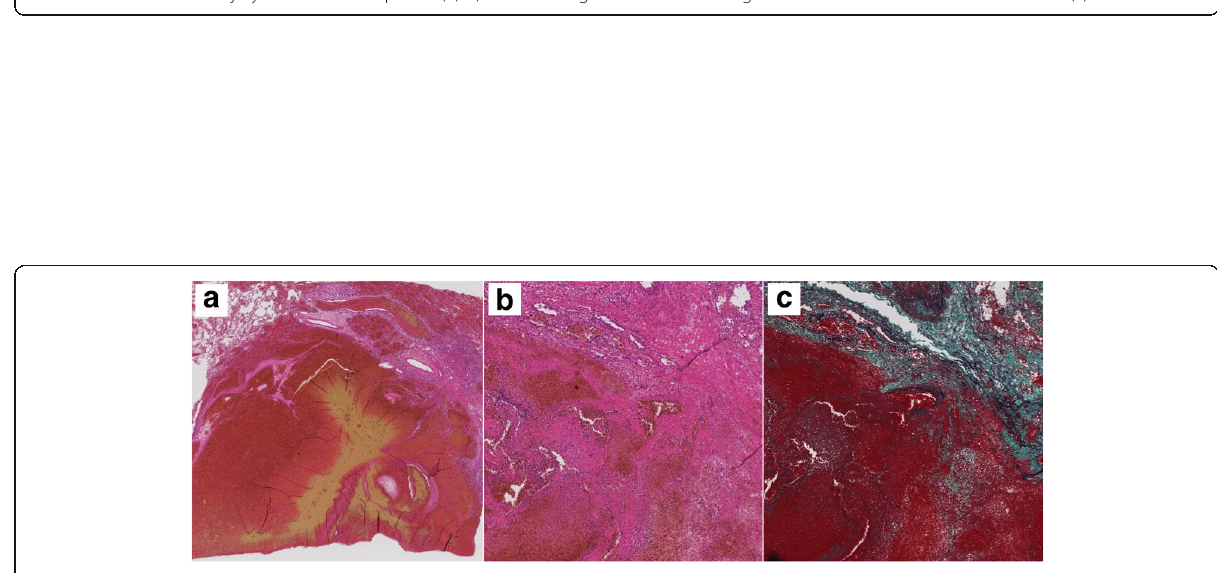
Fig. 5 Histopathological examination showed a hematoma and rupture of a blood vessel wall within the hematoma. a HE-stained section under low magnification. b HE-stained section under high magnification. c Elastica van Gieson ’ s